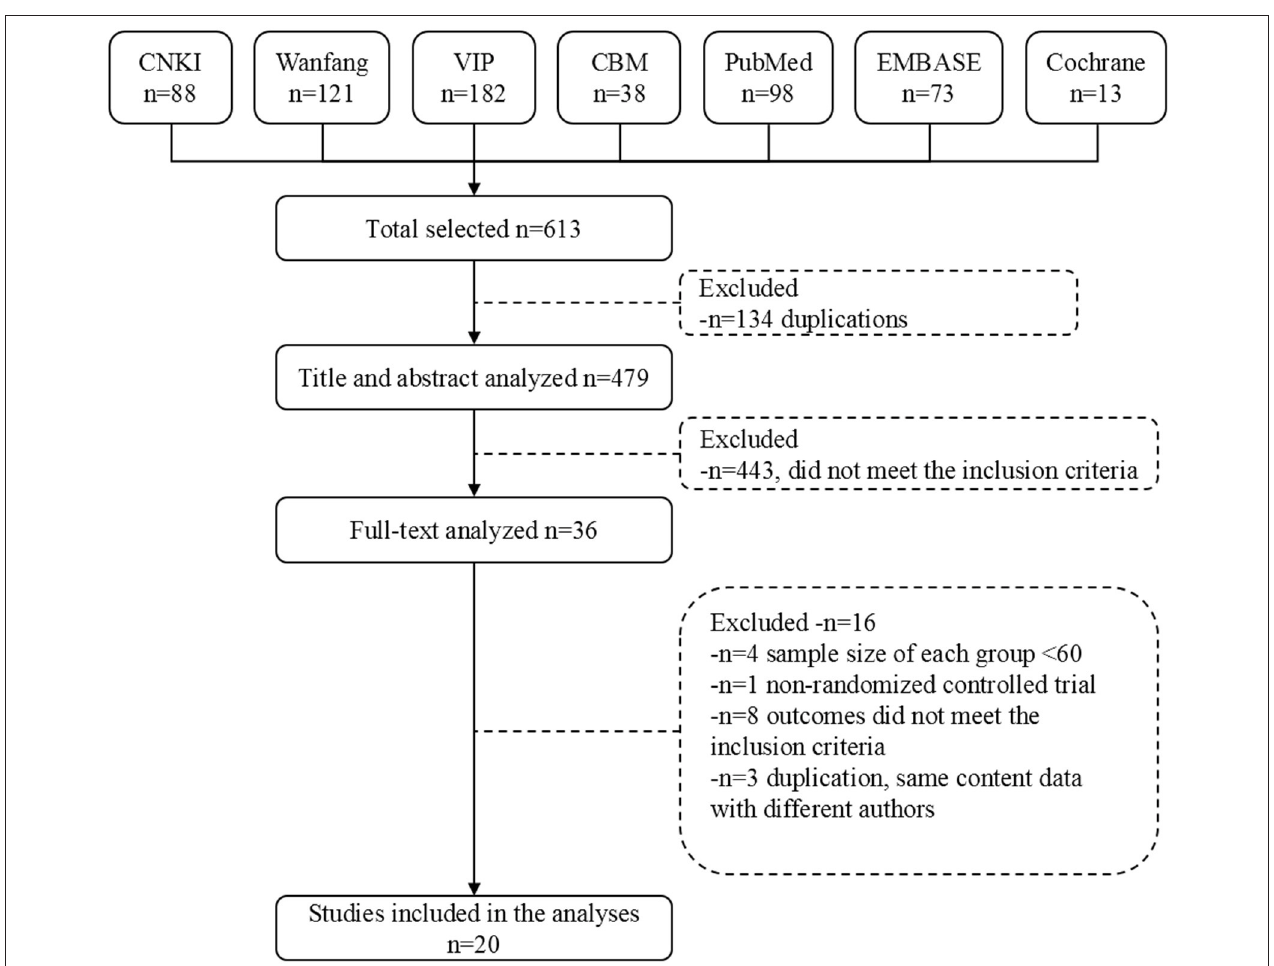
FIGURE 1 | Literature screening